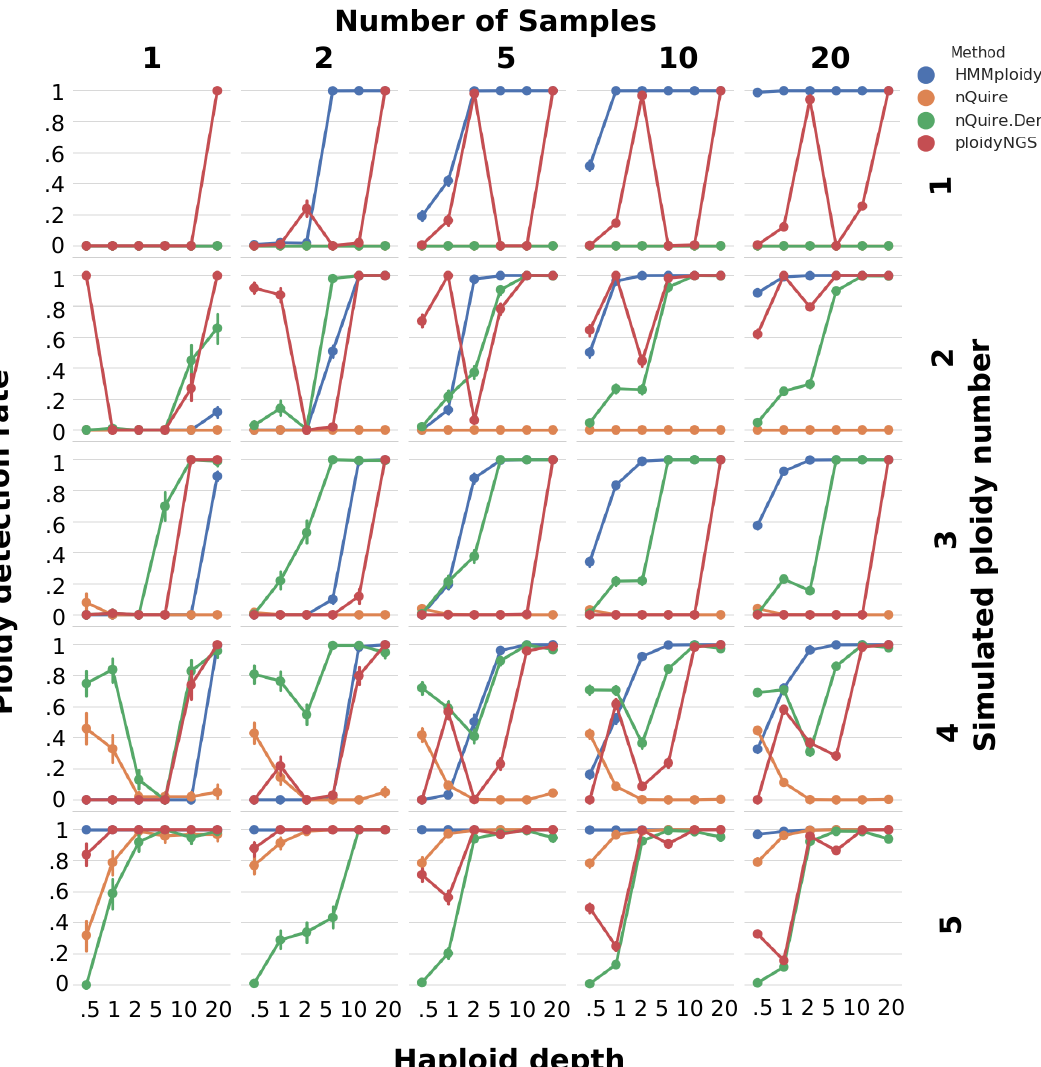
Figure 2. Comparison of ploidy detection rates for different methods at various experimental scenar- ios. The rate of detecting the correct ploidy (y-axis) is shown against the haploid sequencing depth (x-axis) for different sample sizes (on columns) and ploidy levels (on rows). For every simulated ploidy level, at each value of the sequencing depth we generate M genomes 100 times, where M is the number of simulated samples. The ploidy detection rate is the proportion of correctly detected ploidy levels in the genomic windows with the HMM method, and the proportion of correctly detected ploidy levels along each whole genome with the other tested